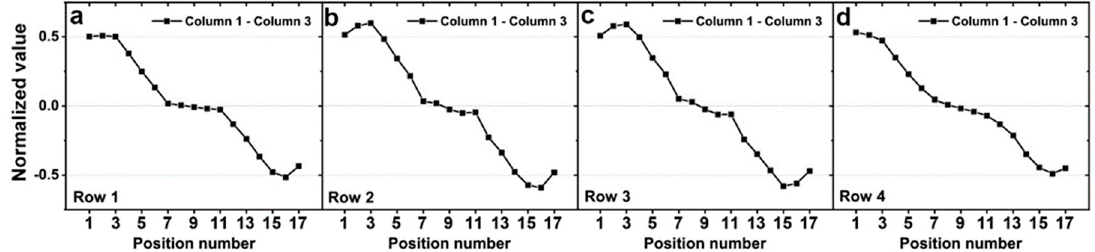
Figure 6. Simulation results of difference between normalized values for column 1 and 3 ( a ) when 1 N of force was applied to row 1, ( b ) when 1 N of force was applied to row 2, ( c ) when 1 N of force was applied to row 3, and ( d ) when 1 N of force was applied to row 4.